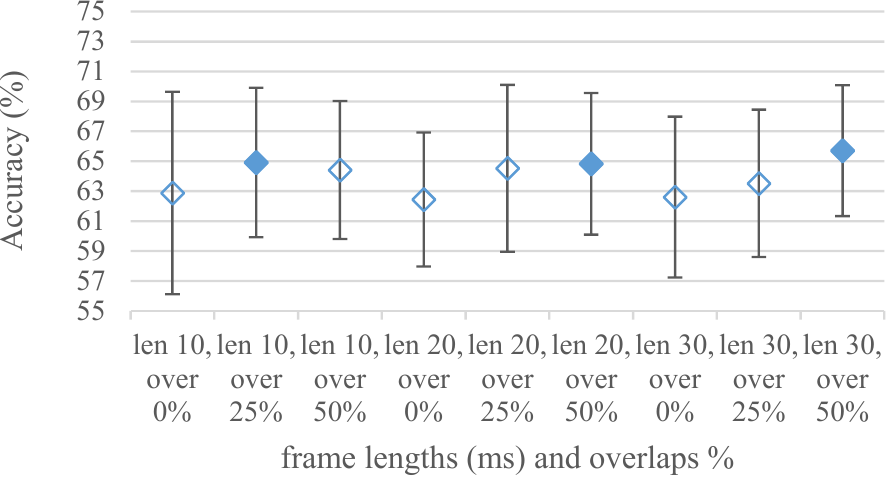
Figure 2. Averaged accuracies and standard deviations for 10, 20, and 30 ms frame lengths (len) with 0, 25, and 50% overlaps (over) and a 4 kHz frequency range. Filled marks show equally performing settings.